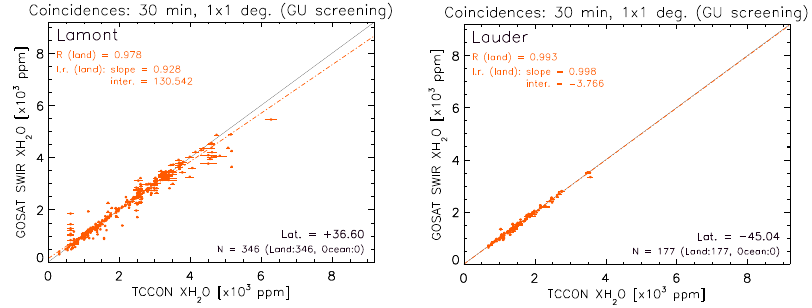
Figure 6. Correction of Figure 6 in [1]. Scatter plot of the GOSAT TANSO-FTS XH 2 O and coincident TCCON soundings (criteria of ± 30 min and ± 1 ◦ in latitude/longitude) at the Lamont ( left ) and Lauder ( right ) TCCON sites. All coincidences were found for TANSO-FTS land